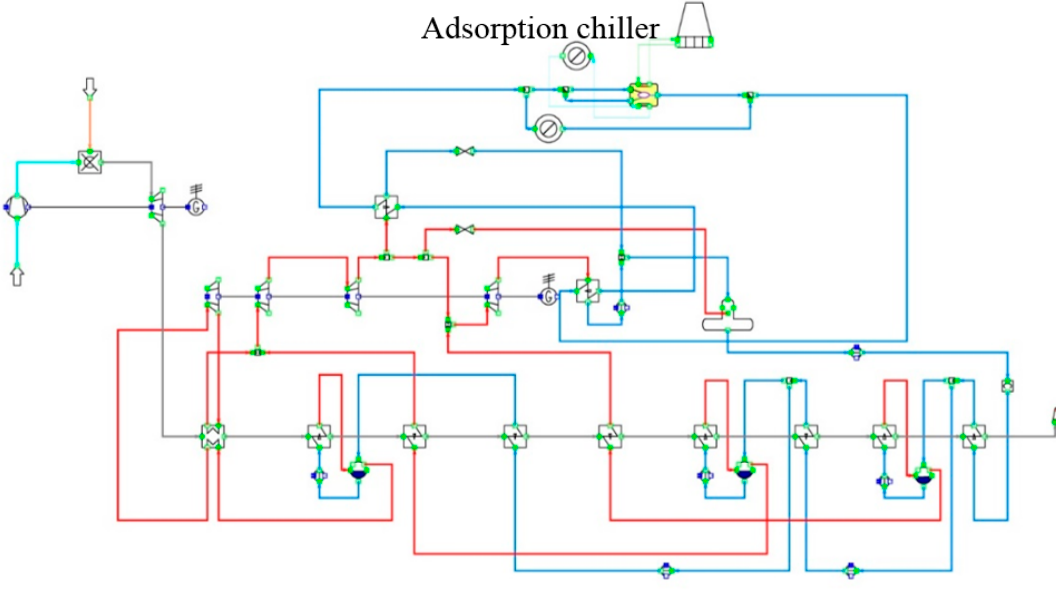
Figure 5. Schematic diagram of a CHP unit cycle with chillers installed, modelled in IPSEpro.